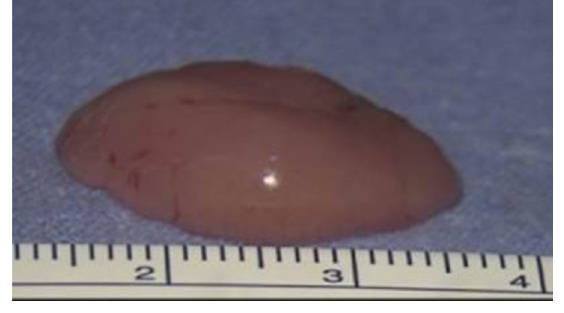
Figure 2 Laryngeal rhabdomyoma after excision: 22 mm × 15 mm × 9 mm.